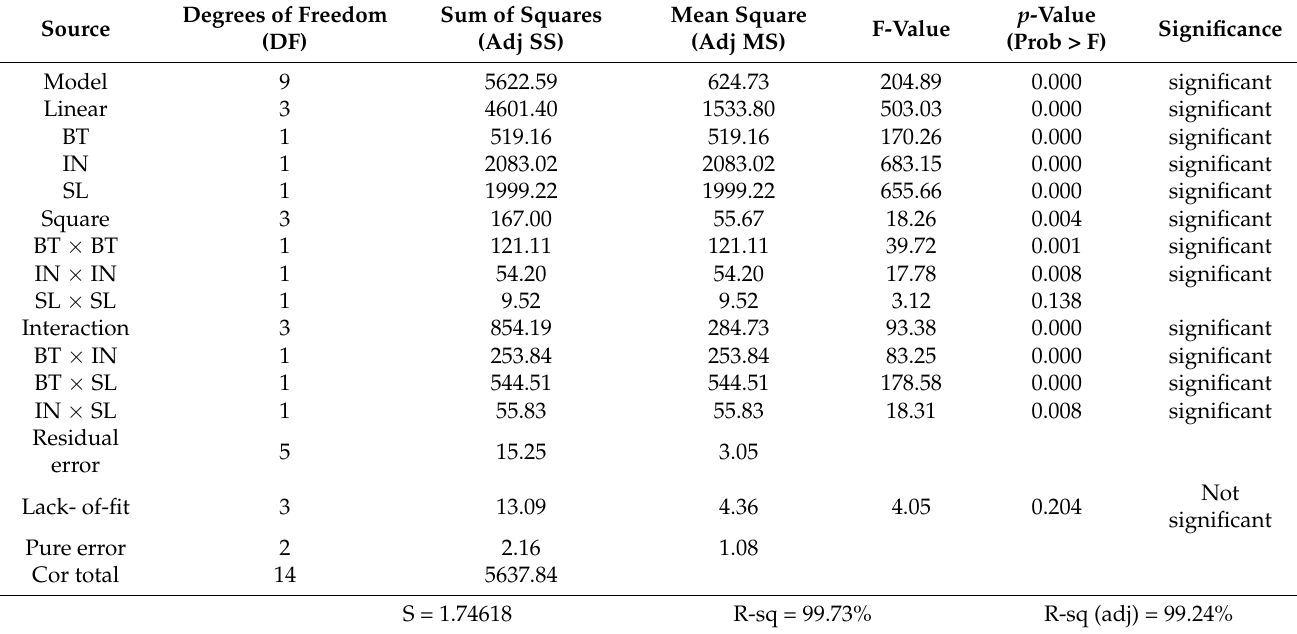
Table 6. ANOVA results of surface